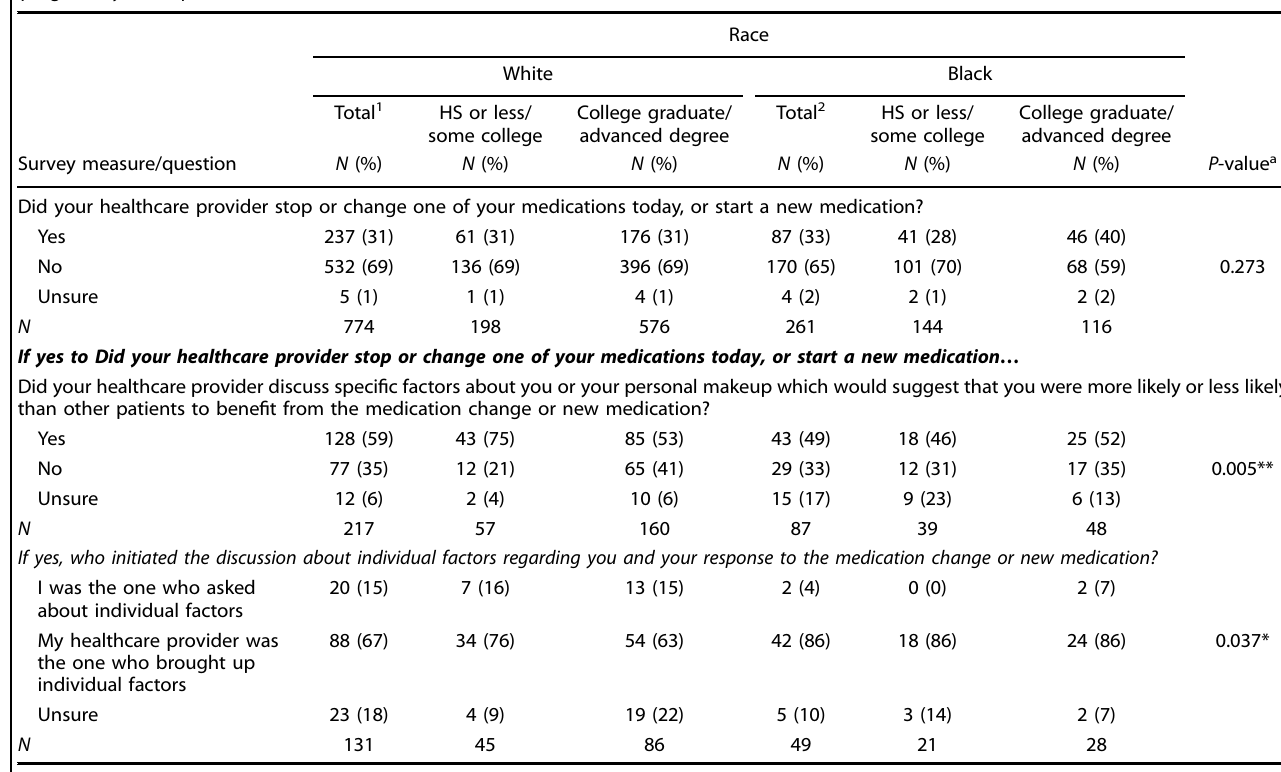
Table 3. Patient recollection of medication changes during clinical visits with providers participating in a pharmacogenomics implementation program by self-reported race and educational